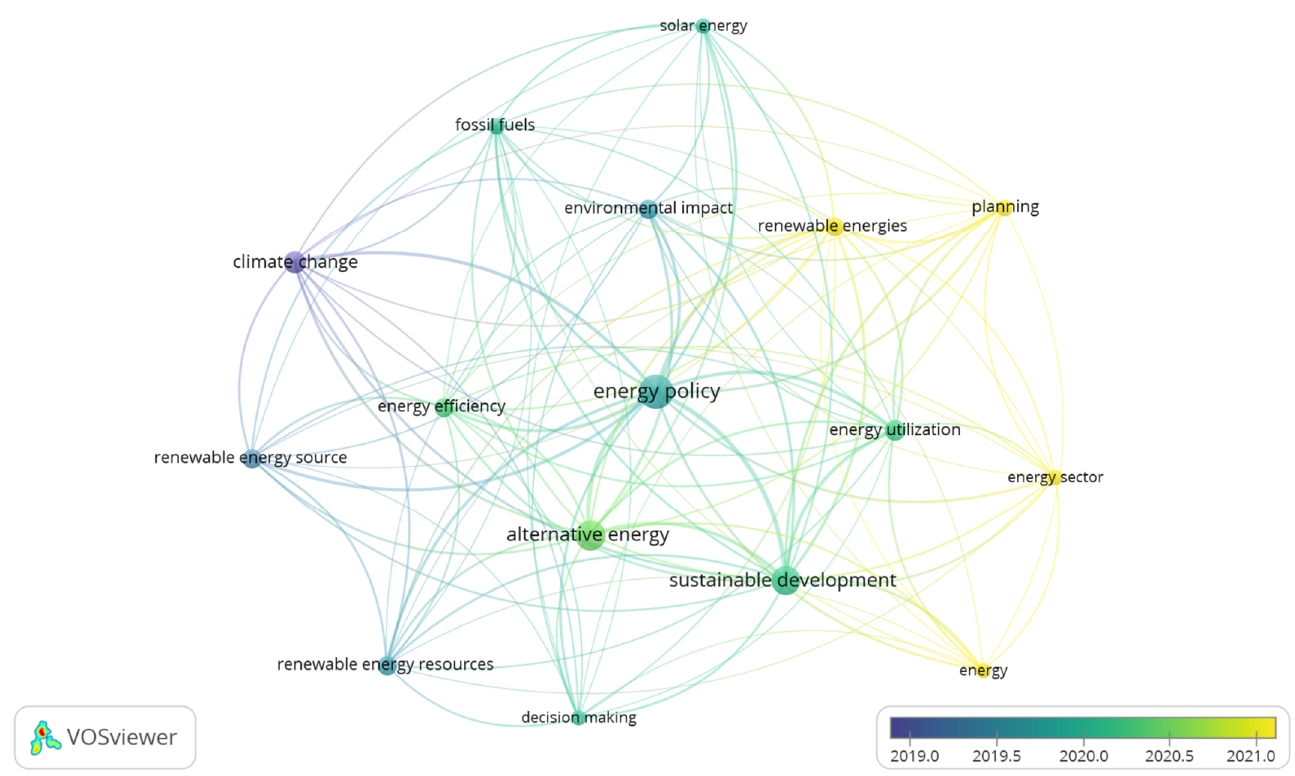
Figure 11. Bibliometric map of index keyword co-occurrence results from Scopus based on Query 26. Counting method: full counting. Minimum keyword co-occurrence is 10. Source: authors’ elaboration performed in VOSviewer (version 1.6.18).